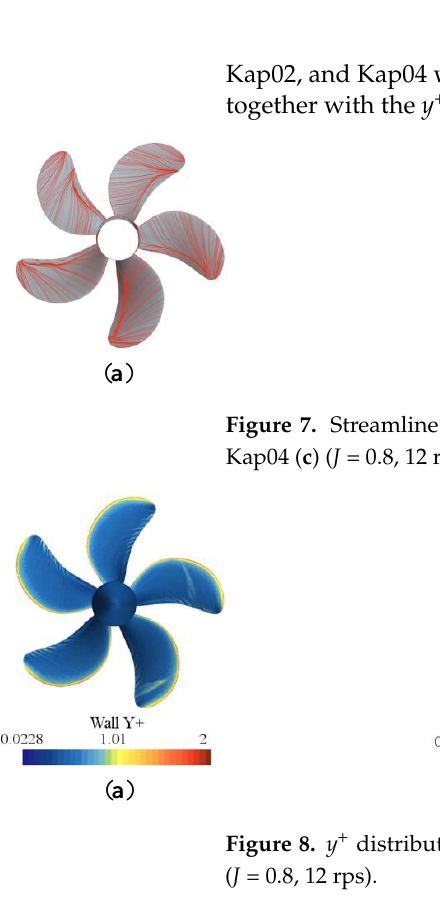
( b ) Figure 6. Open-water performance calculation error of propeller P1727 on model scale in cavitating flow without counting γ transition ( a ) and considering γ transition ( b ) (error = (CFD-EFD)/EFD × 100%. The error of the η o has been labeled in the figure). It can be seen that the results considering γ transition are quite consistent with the EFD (Experimental Fluid Dynamics) data, which possess narrower gap in value within 5% deviation than those ignoring transition phenomenon. The calculation error of K T no- tably dwindled by 16%~51%, in contrast to the error magnification of 10 K Q at medium and high advance speeds, which resulted in the calculation error of η o sharply narrowing by a general range between 51% and 86%, with the calculation efficiency nearly identical to EFD data when J = 0.3. The comparison result shows the necessity of counting transition